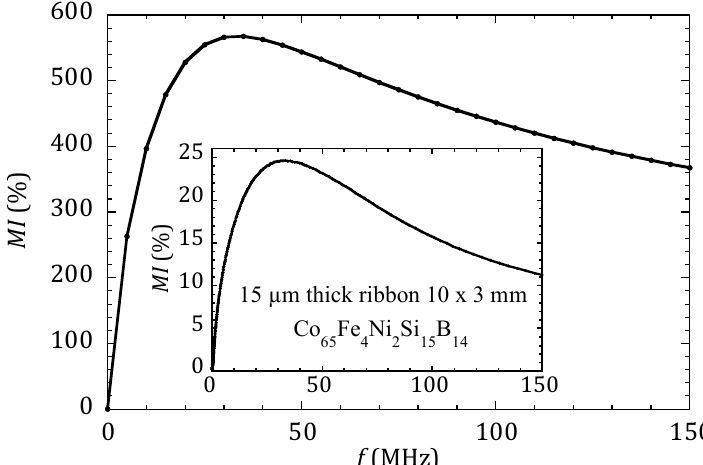
Figure 3. Magneto-impedance ratio MI as defined in Equation (2), calculated using FEM for the case of a planar sample 1 mm wide and 20 µ m thick, with the permeability µ max = 5000 µ 0 . For comparison, the inset shows the MI ratio experimentally measured in an amorphous ribbon.